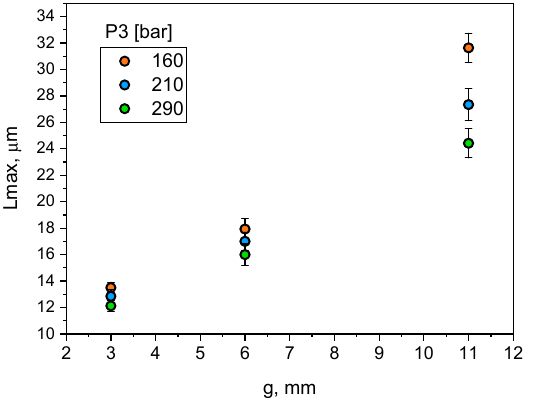
Figure 12. Influence of casting wall thickness and compression pressure on L max parameter.